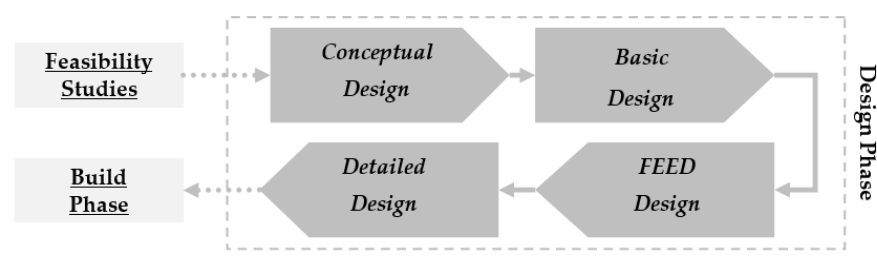
Figure 2. The four stages of housing design phase.